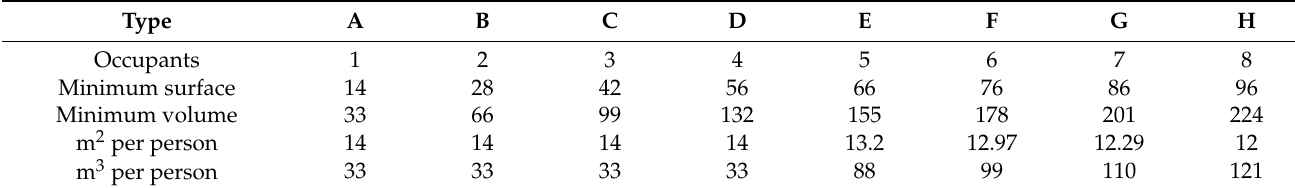
Table 9. French dwelling definition [56]. Surfaces and volumes per person and